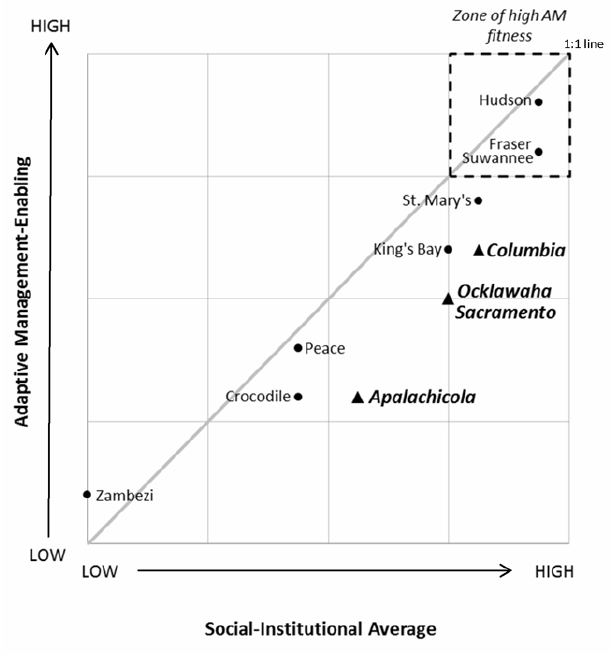
Fig. 3 . Identifying AM fitness using the IMC. AM fitness is the degree to which favorable AM conditions are in place in a watershed, as indicated by a watershed\\\'s proximity to the 1:1 line. The Hudson, Fraser, and Suwannee watersheds fell within the zone of \\\"high AM fitness\\\" (indicated by the dotted box), as their Social-Institutional scores were high and in 1:1 alignment with their respective AME